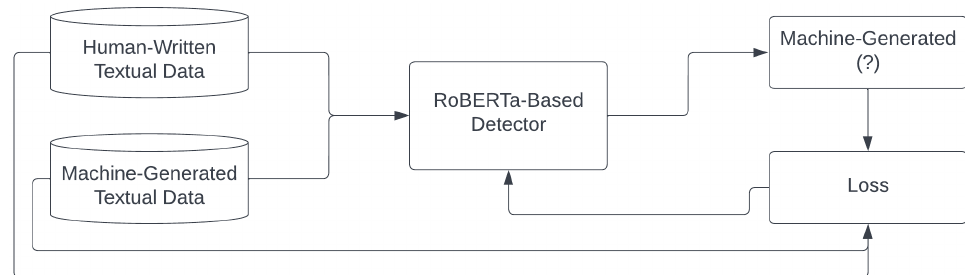
Figure 2. The RoBERTa-based detector general training